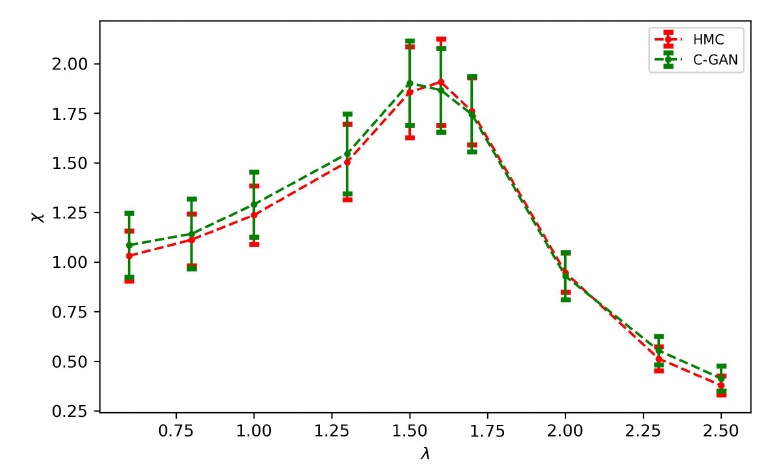
Figure 10: Susceptibility and its standard deviation on λ samples with bin size of 100.